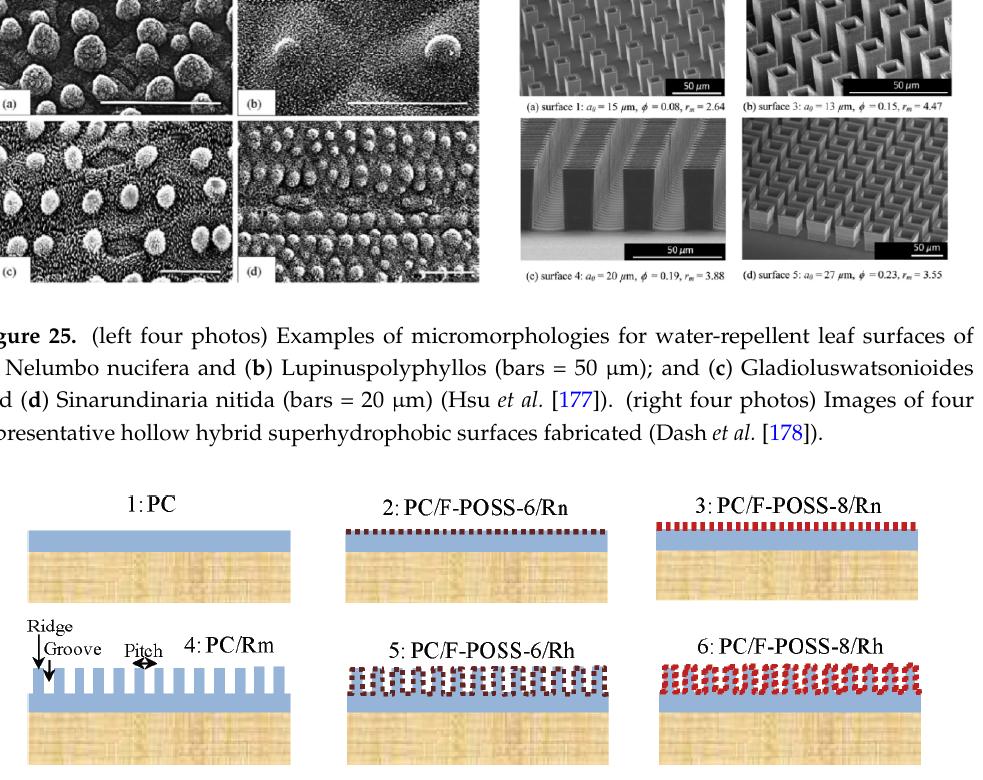
Figure 26. Anti ‐ icing coating design cases where Rn denotes nanoscale roughness, Rm microscale